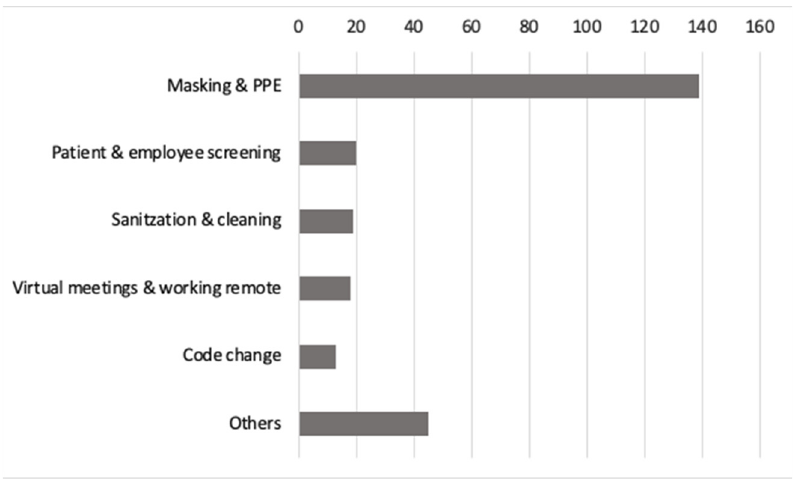
Figure 2. Themes and counts of procedure changes due to COVID-19.